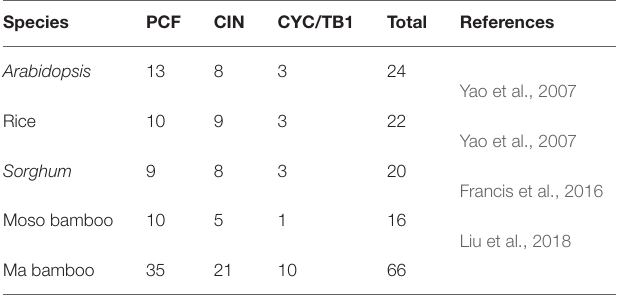
TABLE 1 | The number of TCP family members in five plant species.